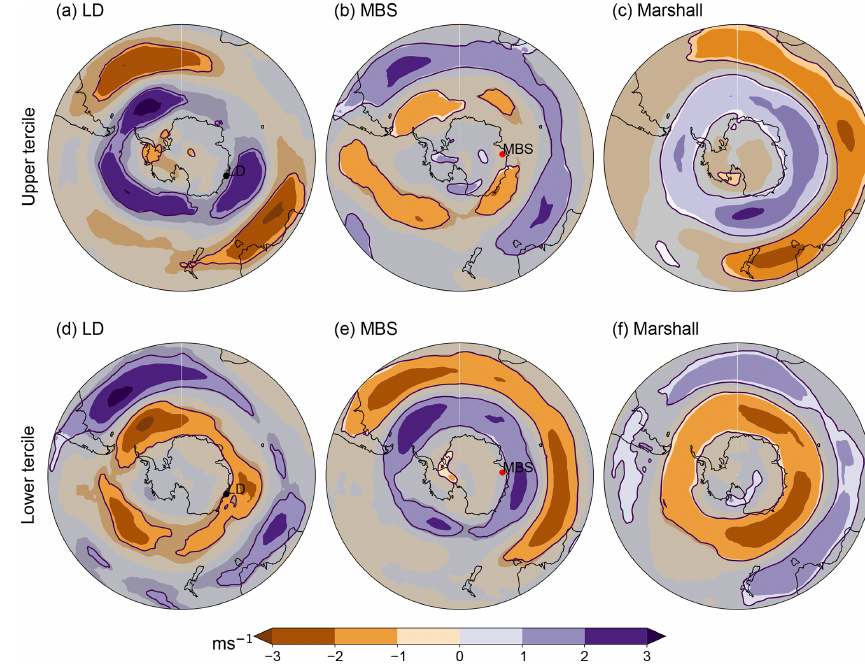
Figure 10. Zonal wind anomaly composite maps (ms − 1 at 500hPa) during the upper (a) and lower (d) tercile (November–February) of the detrended, log-transformed summer sea salt concentrations from the Law Dome (LD, Dome Summit South site) record over the period 1979–2015. (b, e) The same as (a) and (d) except using the detrended, log-transformed annual sea salt concentrations from the Mount Brown South site average (MBS, December–February) over the period 1979–2016. (c, f) The same as (b) and (e) except using the detrended SAM Marshall Index (December–February). The red dot indicates MBS, and the black dot indicates LD. Significant anomalies are within the upper and lower purple contour lines, where p <